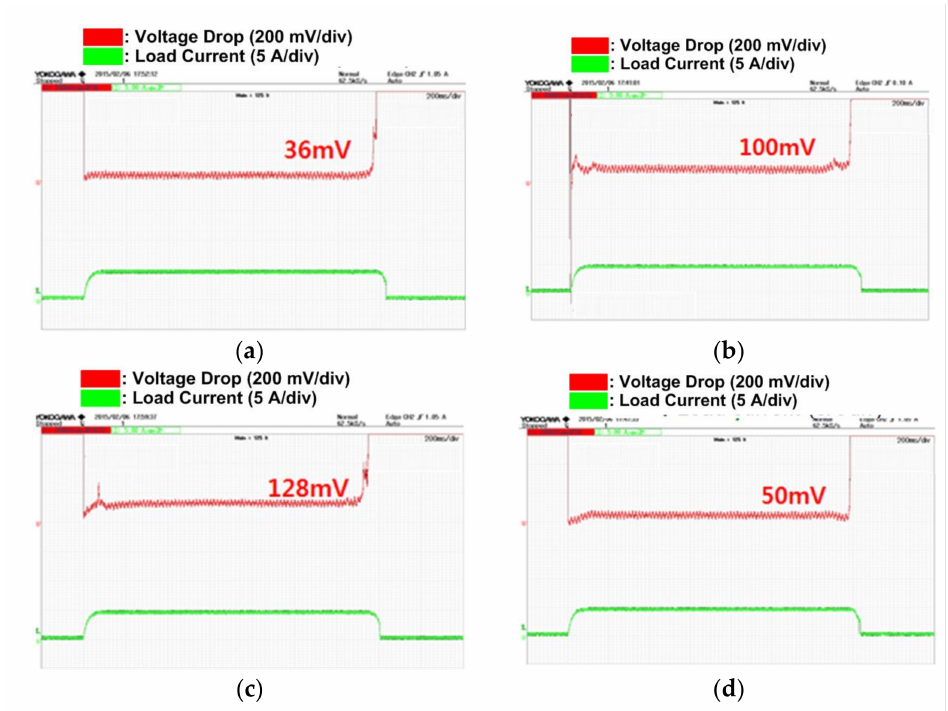
Figure 4. Example of voltage/current waveforms between electrode contacts according to electrode material for 400 V/5 A experimental conditions (time: 200 ms/Div); ( a ) AgNi-Cu, ( b ) AgSnO2-Cu, ( c ) AW18-Cu, and ( d )